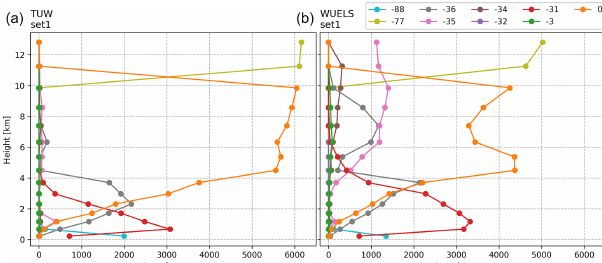
Figure 12. Number of flagged observations as function of height (flag explanation in the text) – separately for TUW set1 (a) and WUELS set1 (b)